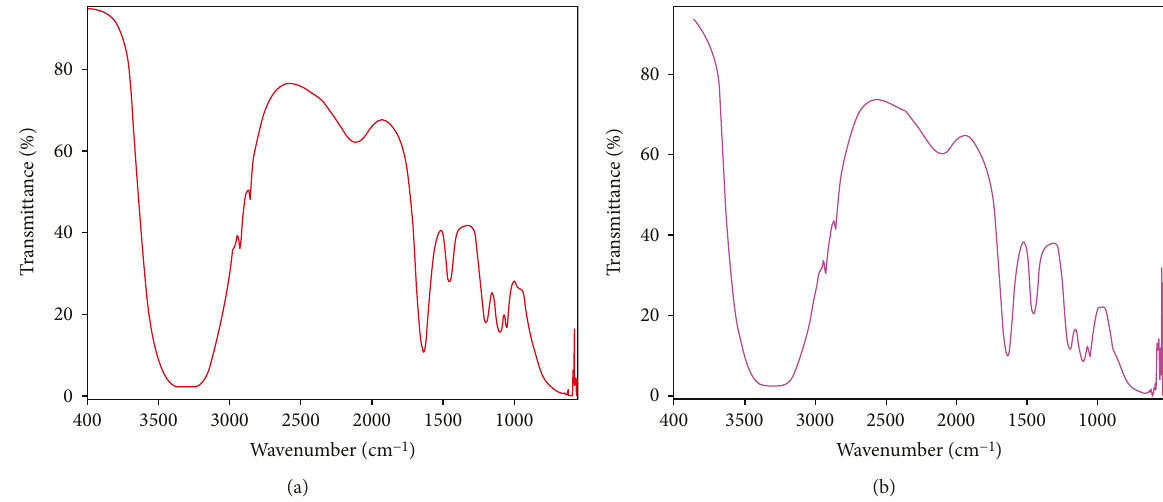
Figure 6: The FTIR spectrum of Ppy samples with (a) ferric chloride and (b) ammonium persulphate.